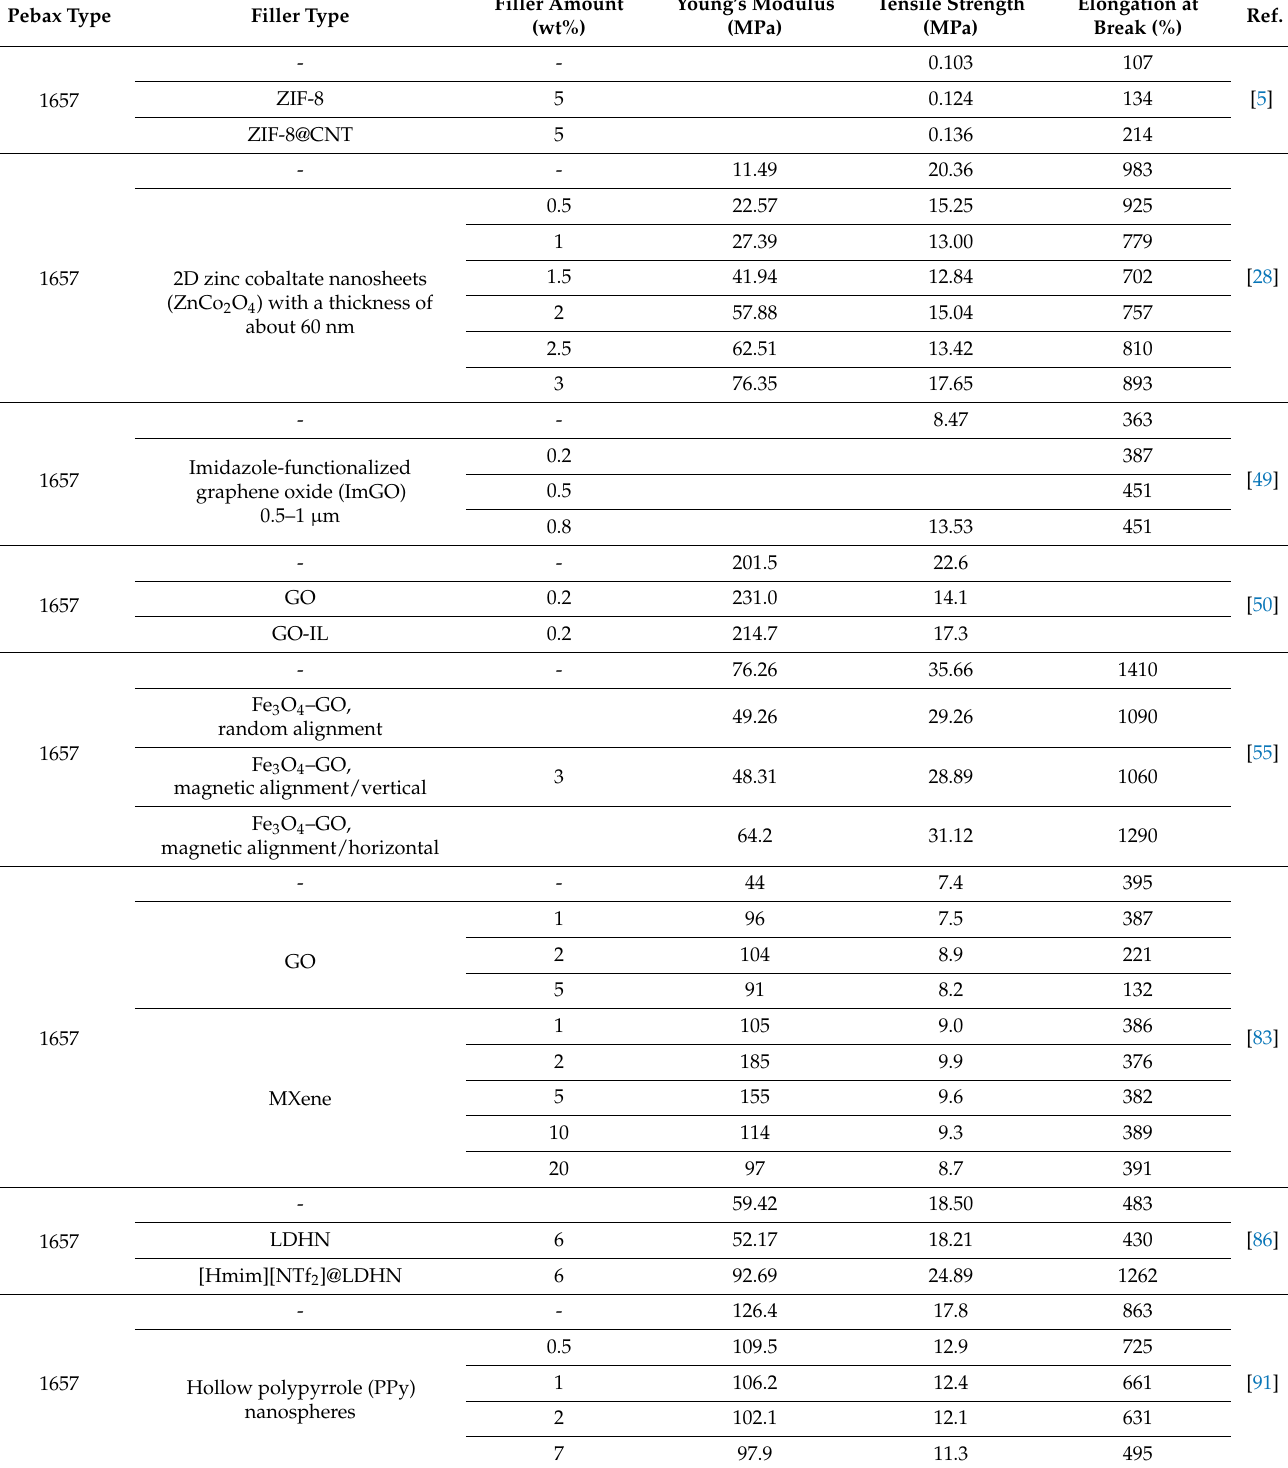
Table 2. Mechanical properties of selected Pebax-based